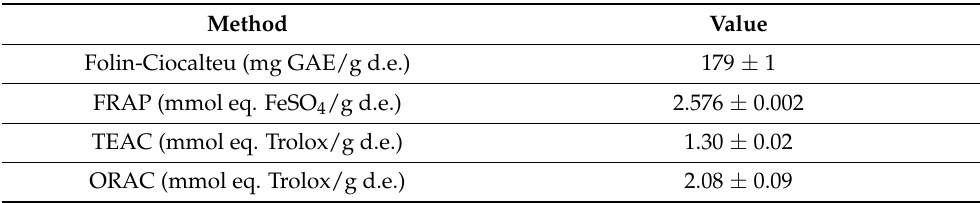
Table 2. Total phenolic content and antioxidant capacity of LME. Method Value Folin-Ciocalteu (mg GAE/g